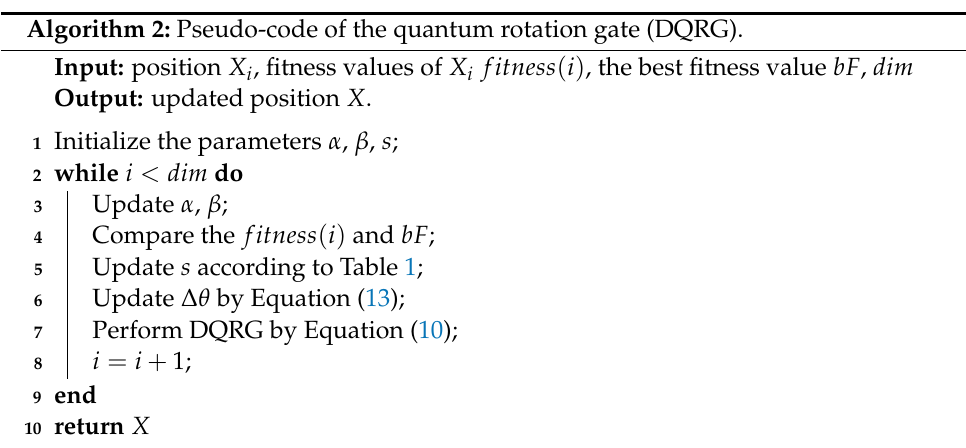
Algorithm 2: Pseudo-code of the quantum rotation gate